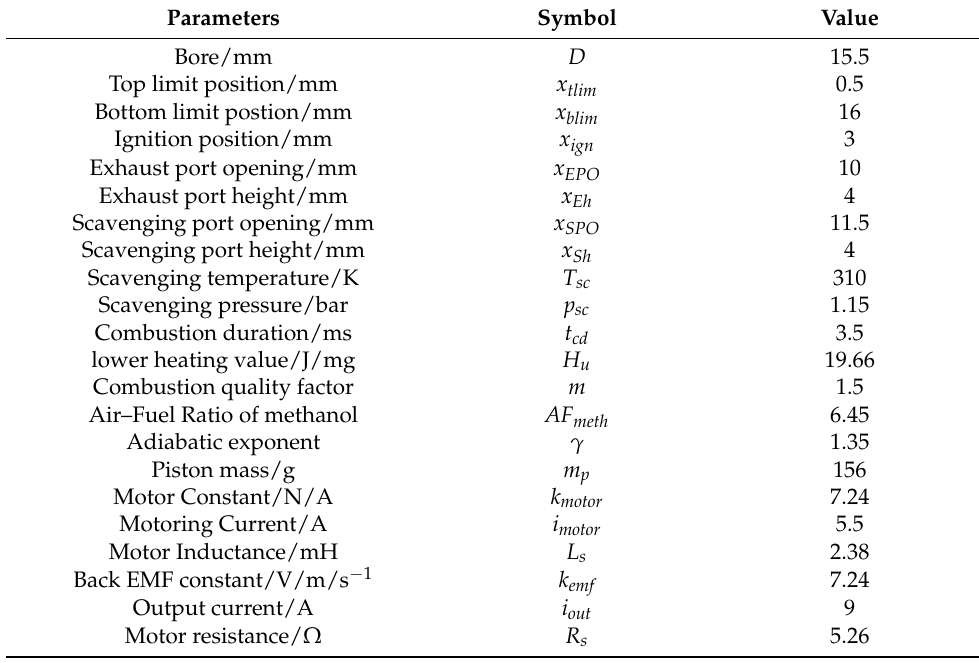
Table 1. Specifications of the miniature free-piston generator (MFPG) prototype.